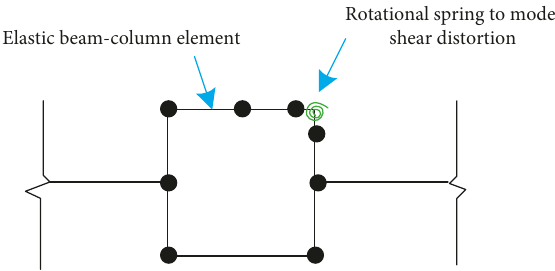
Figure 6: Schematic representation of a typical panel